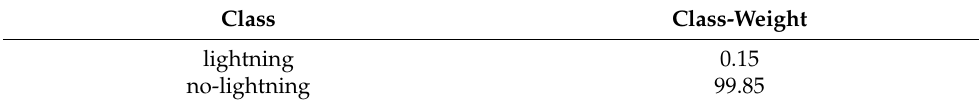
Table 2. Measured class-weight of the training split for the 2016/2017 data